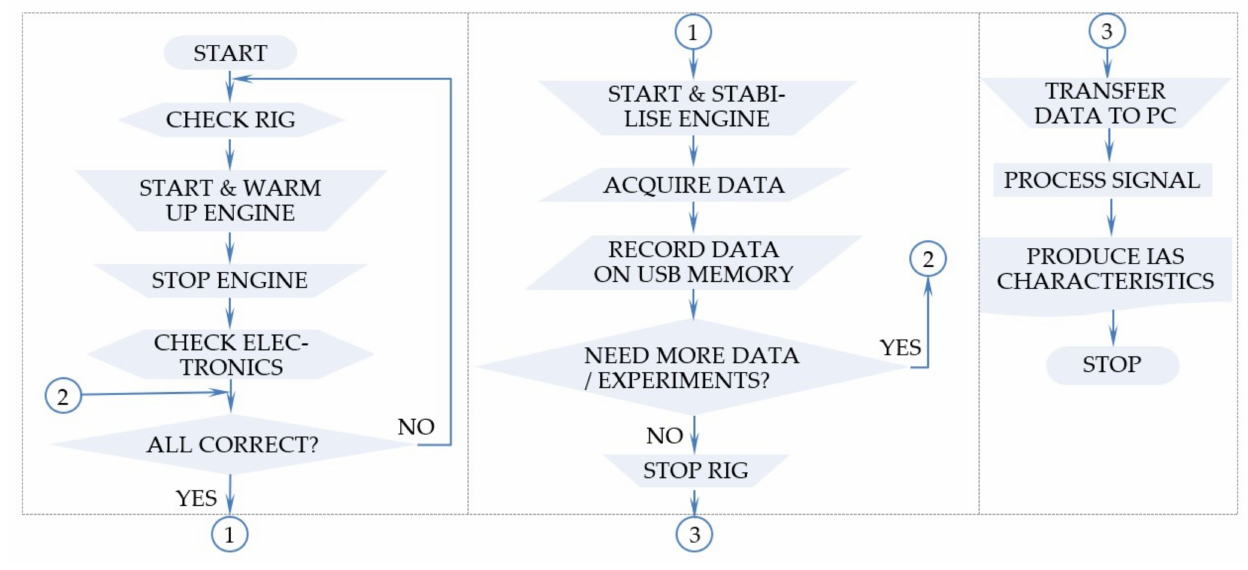
Figure 9. ICE operation IAS signal